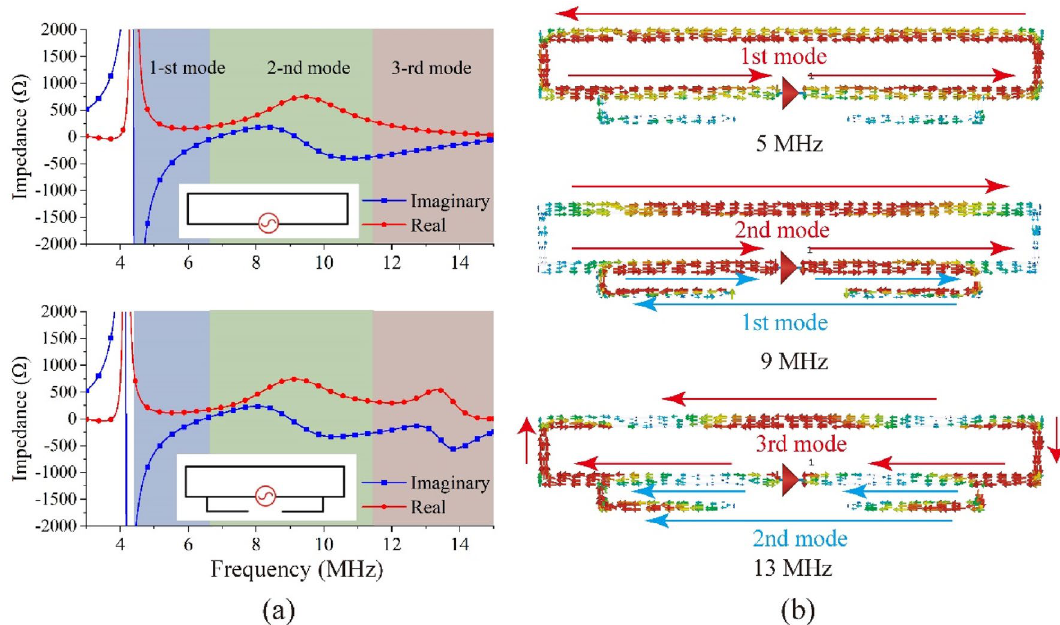
Figure 3. ( a ) Impedances of the initial folded dipole and the modified folded dipole, ( b ) surface current of modified folded dipole in three